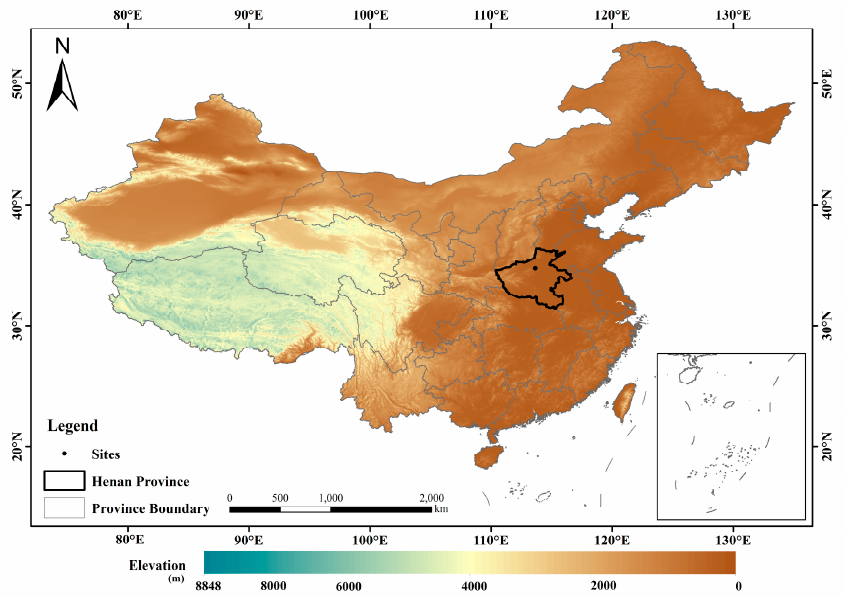
Figure 1. Map of the study area. Colors represents the elevation and dot represents the study site at Zhengzhou City in Henan Province.